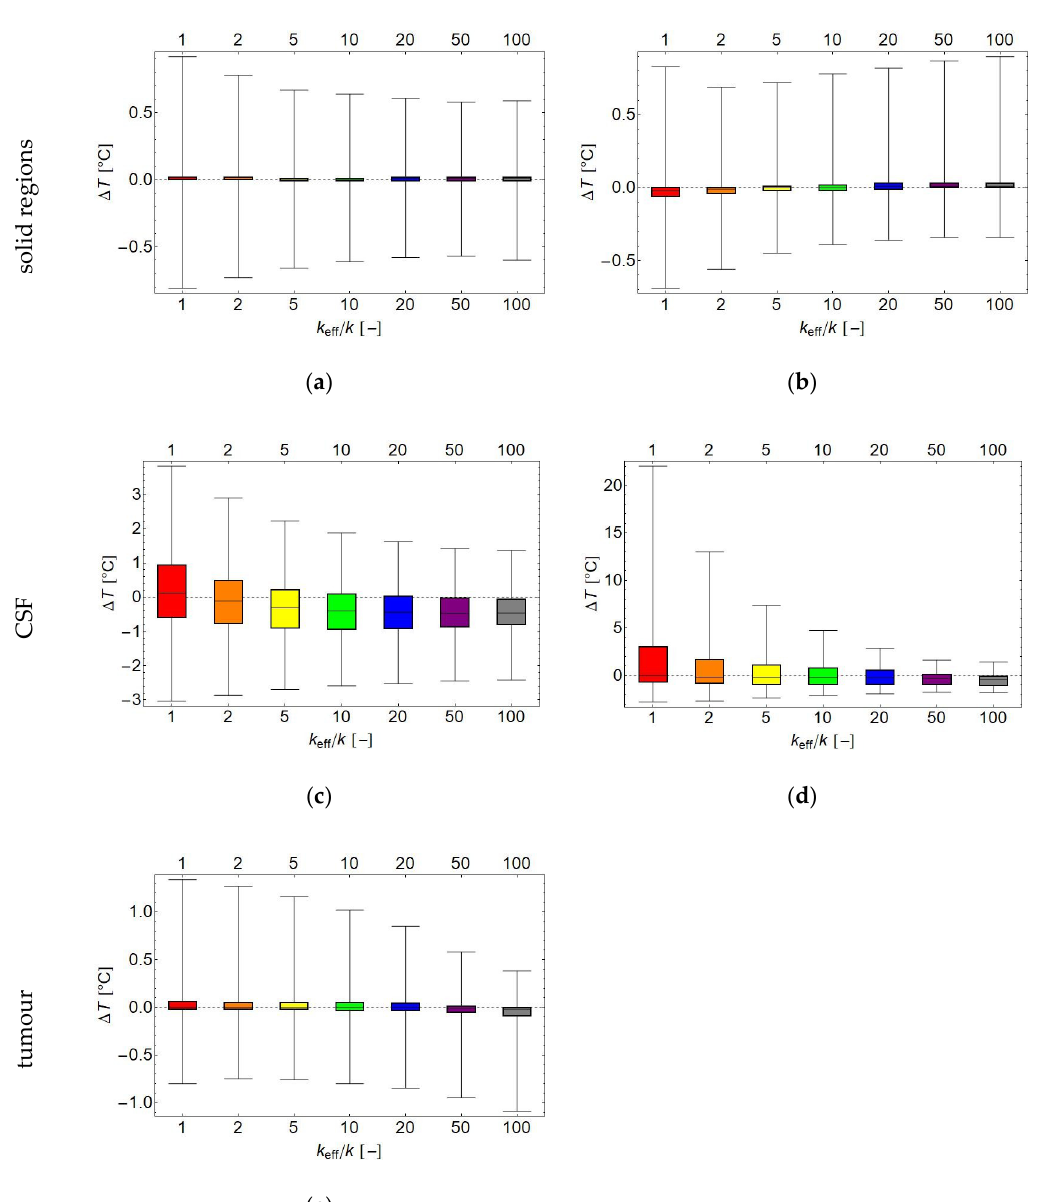
Figure 9. Box whisker plots of the temperature differences for the solid regions except tumour ( a , b ), the CSF ( c,d ) and the tumour ( e ) as predicted by the fluid model and the solid model ( k eff / k = 1 ) and the high- k models for the pre-operative, respectively the post-operative case. A high- k model with higher k eff tends to slightly underestimate the temperature, but has smaller error bars. Horizontal axis: k eff / k , vertical axis temperature in °C.